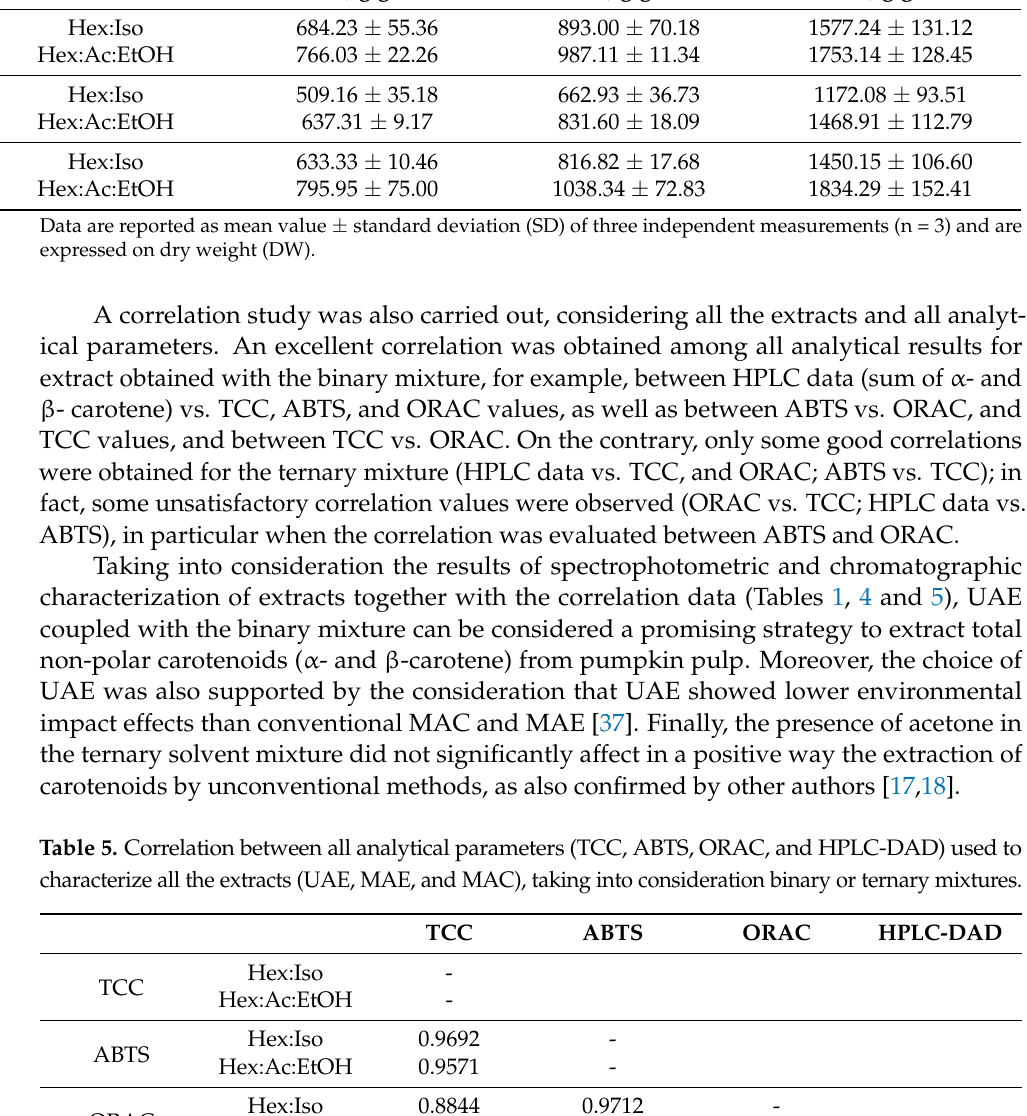
Table 4. Content ( µ g/g, DW) of α -carotene, β -carotene, and total non-polar carotenoids in the extracts. Extraction Technique